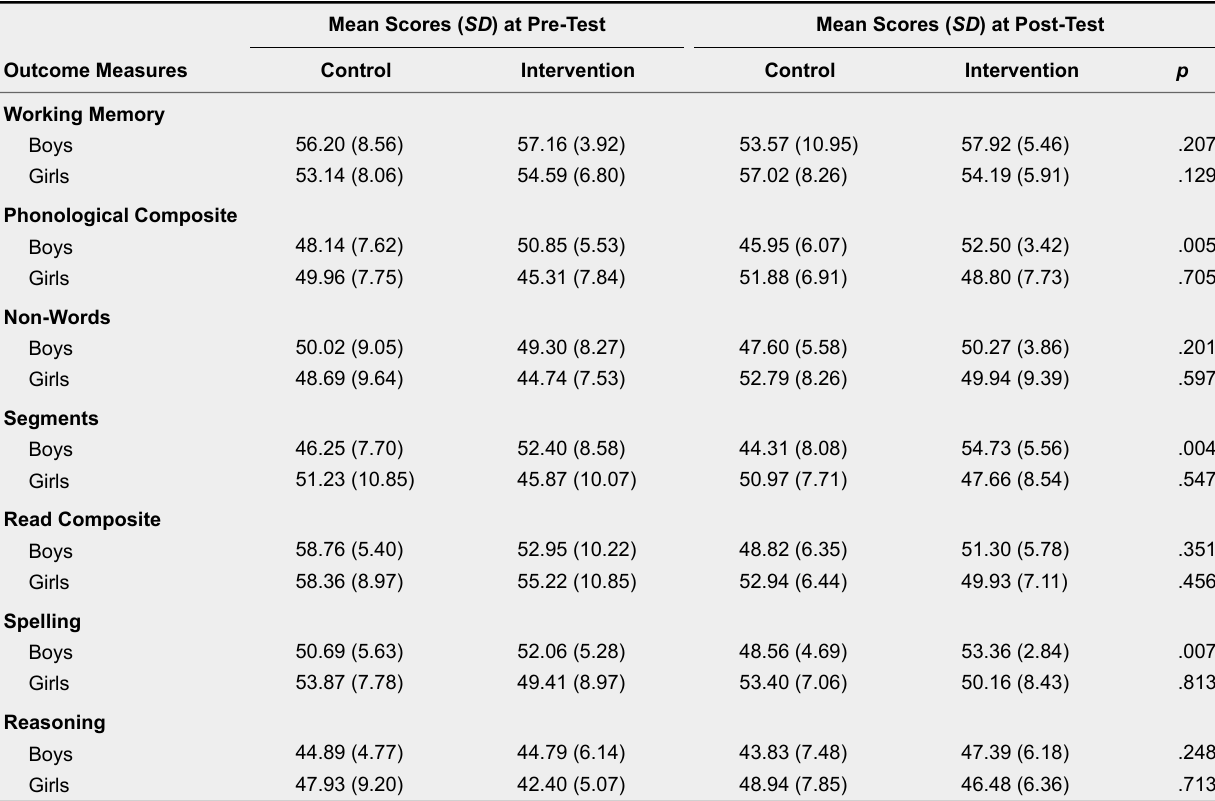
Boys and Girls Means, Standard Deviation (SDs) at Pre- and Post-Testing for Control and Intervention Conditions.